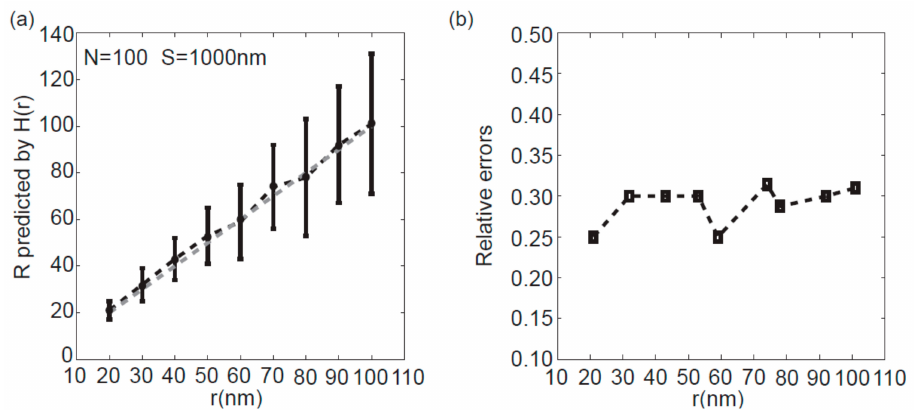
Figure 3. ( a ) Peak analysis results for nine modeled SMLM images containing 10 randomly distributed clusters with di ff erent cluster radius (20 nm to 100 nm). ( b ) The relative errors of cluster radius predicted by peak analysis versus the cluster radius.